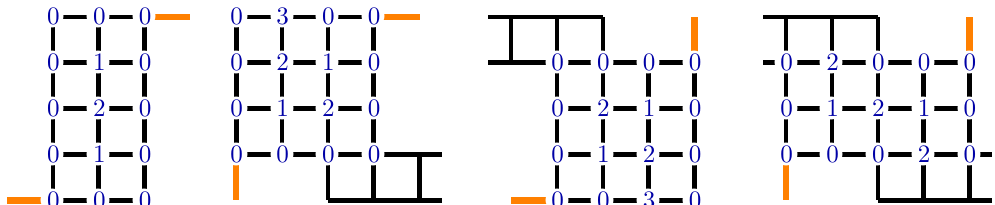
Figure 6 . Number of Bethe roots in the undeformed distinguished Q-functions for the four short multiplets that form the Konishi multiplet. As described in [12], the four Q-systems are compatible Z and due to symmetry transformations that suppress due to certain roots being placed at u = i 2 di(cid:11)erent Q-functions in g